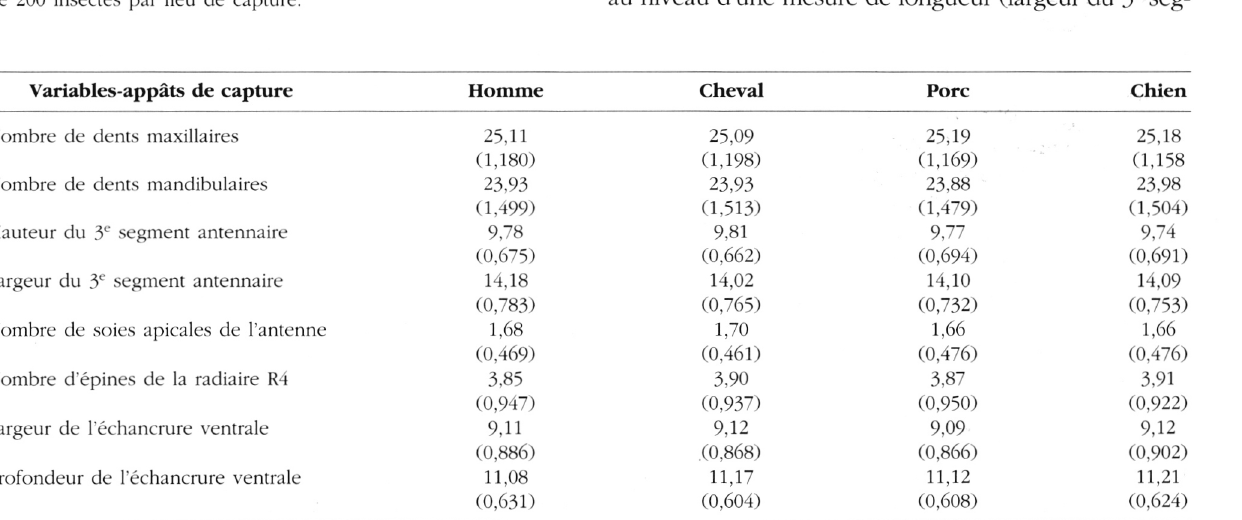
Tableau II. — Regroupements par lieux similaires au niveau de chaque variable des simulies capturées sur appât humain à Nuku- Hiva en 1972 et 1992. Les regroupements sont effectués par ANOVA et examen visuel des distributions de fréquences. Les effectifs sont de 200 insectes par lieu de capture.